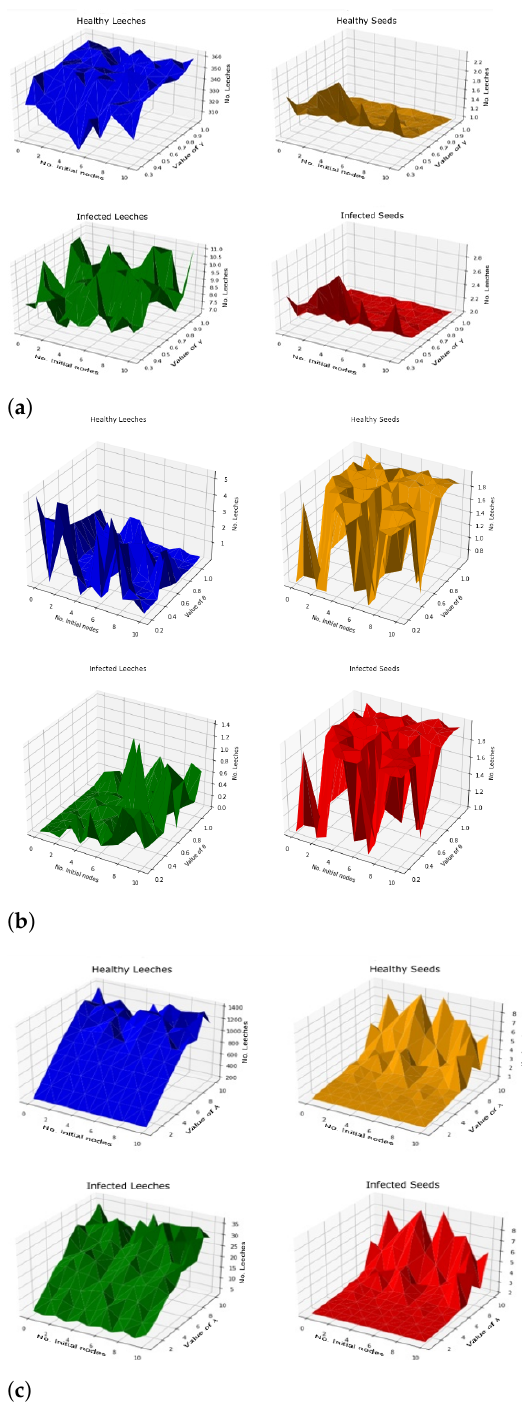
Figure 10. Average number of healthy and infected peers under a malware attack for different values of γ , η , and λ . ( a ) Variation of infected nodes and γ . ( b ) Variation of infected nodes and θ . ( c ) Variation of infected nodes and λ